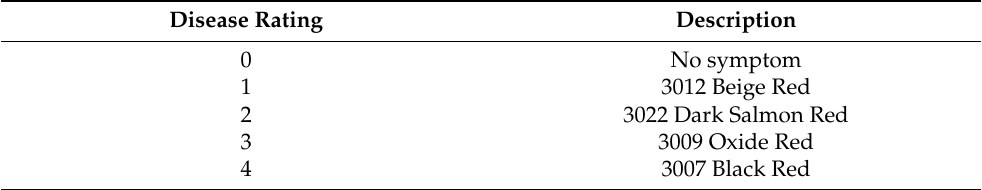
Figure 2. The disease rating of reddish discoloration of jackfruit pulps (rating 0–4). ( a ) Disease rating 0; ( b ) disease rating 1; ( c ) disease rating 2; ( d ) disease rating 3; ( e ) disease rating 4. Table 2. The disease rating of reddish discoloration of jackfruit pulps (developed from this study).